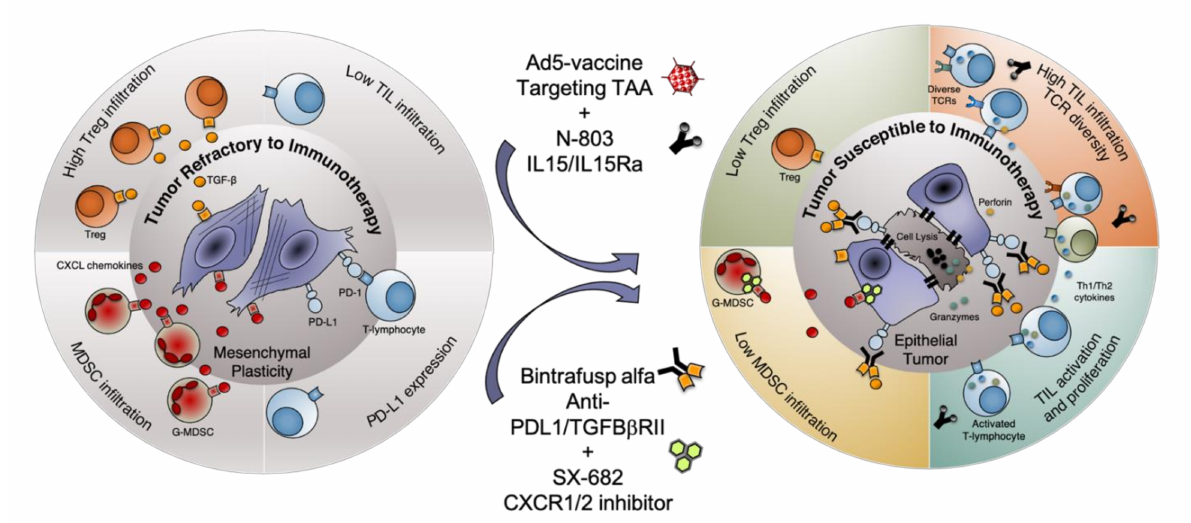
Figure 6. Schematic representation of the mechanism of action of the combination Ad5-vaccine, N-803, Bintrafusp alfa and SX-682. G-MDSC = granulocytic myeloid-derived suppressor cells. TCR = T-cell receptor. TIL = tumor-infiltrating lymphocyte. Tregs = regulatory T